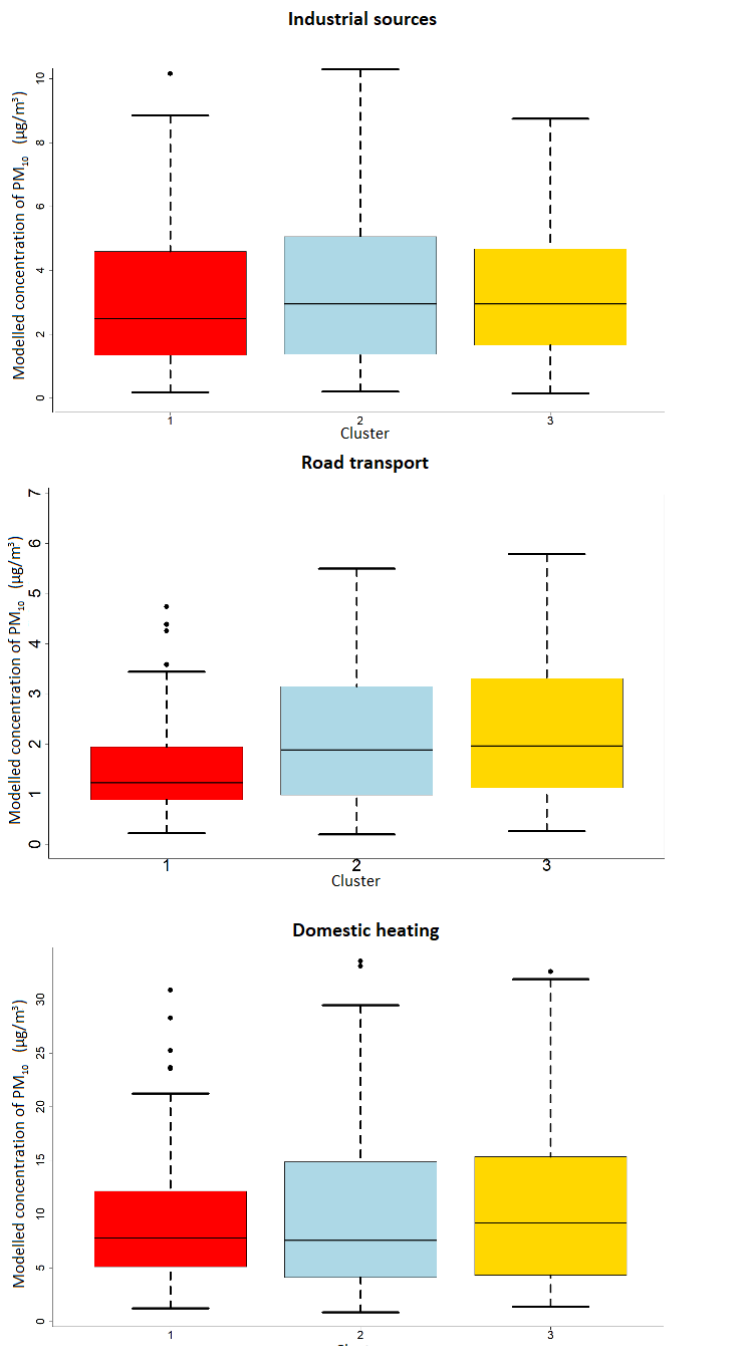
Figure 11. Boxplot of the modelled PM 10 concentrations using the ADMOSS for individual source groups and individual clusters Boxplot of the modeled PM 10 concentrations using the ADMoSS for individual source groups and individual clusters—the boxplots are colored in accordance to their cluster in the cluster